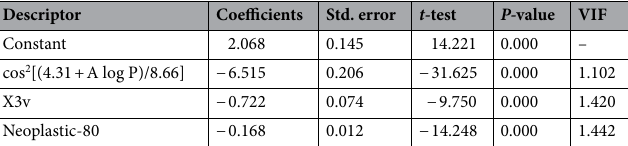
Table 1. Characteristics of molecular descriptors in MLR model.